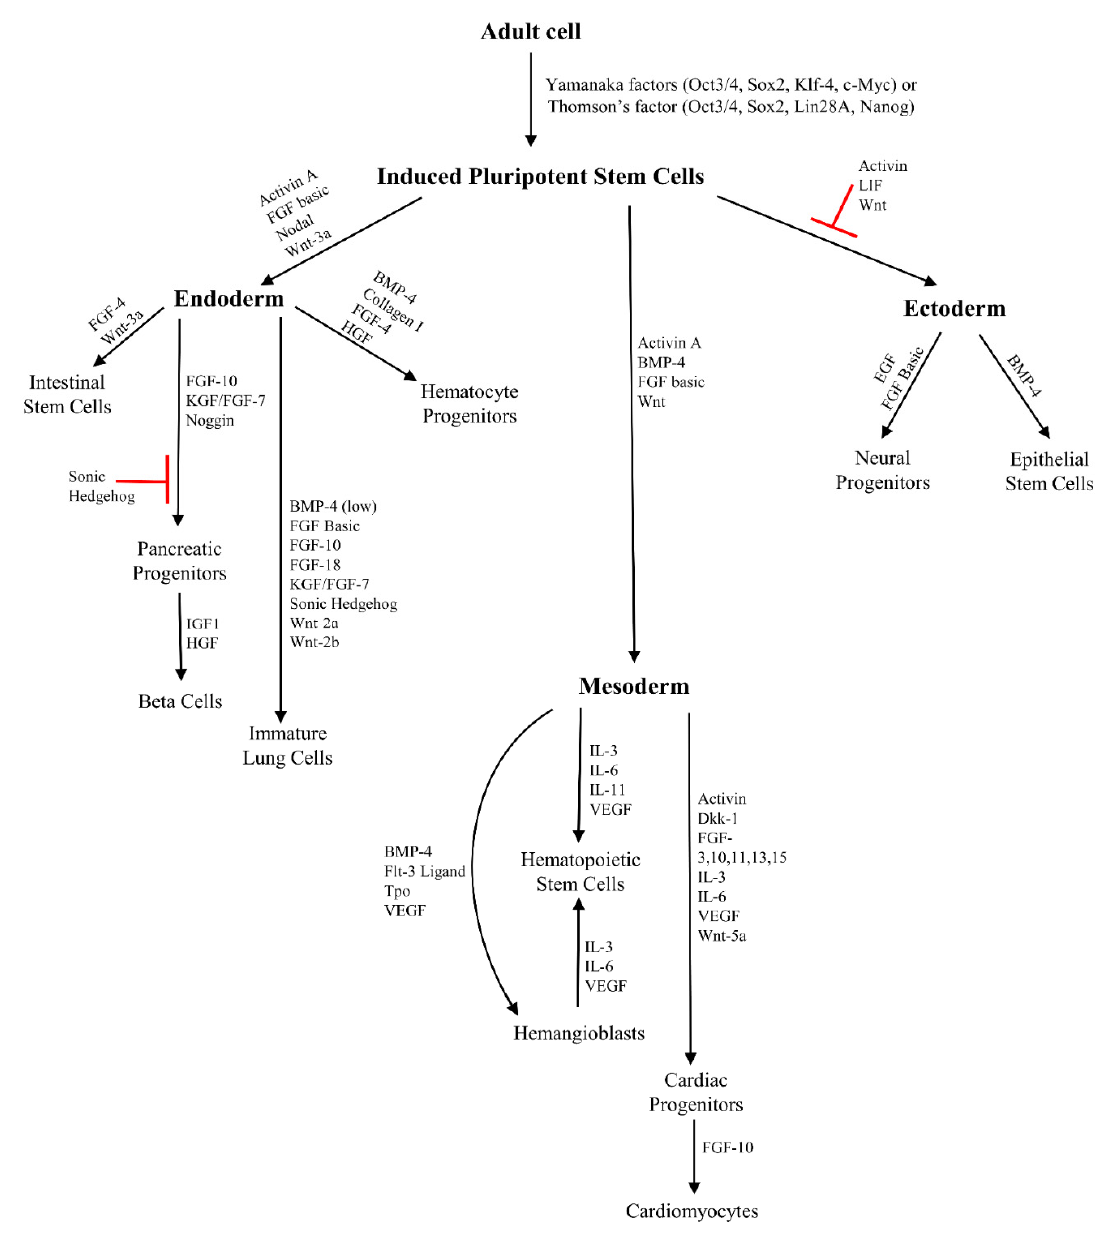
Figure 2. Schematic of somatic cells reprogramming with Yamanaka (Oct3/4, Sox2, Klf-4, and c-Myc) or Thomson (Oct3/4, Sox2, Lin28A, and NANOG) and their potency to differentiation with lineage-specific markers.